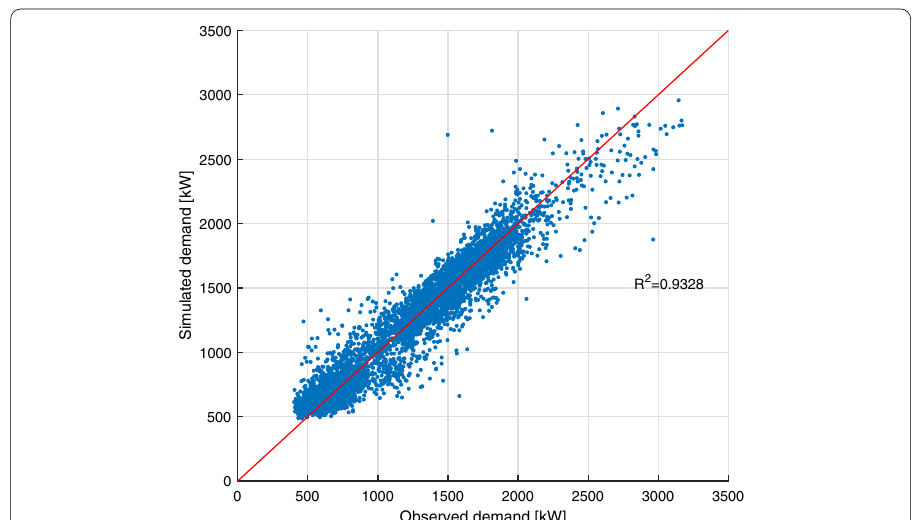
Fig. 2 Accuracy of ANN estimation: observed heat demand vs demand expected according to ANN results